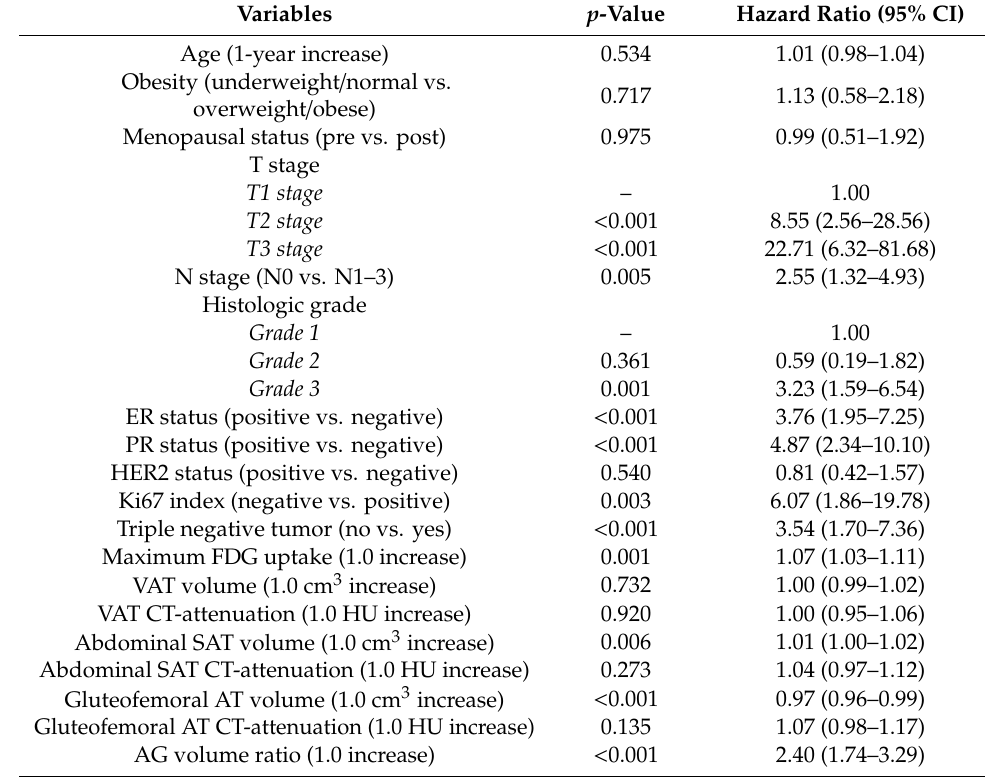
Figure 2. ( a ) Distributions of volume and ( b ) CT-attenuation for visceral adipose tissue (VAT), abdominal subcutaneous adipose tissue (abdominal SAT), and gluteofemoral adipose tissue (gluteofemoral AT).